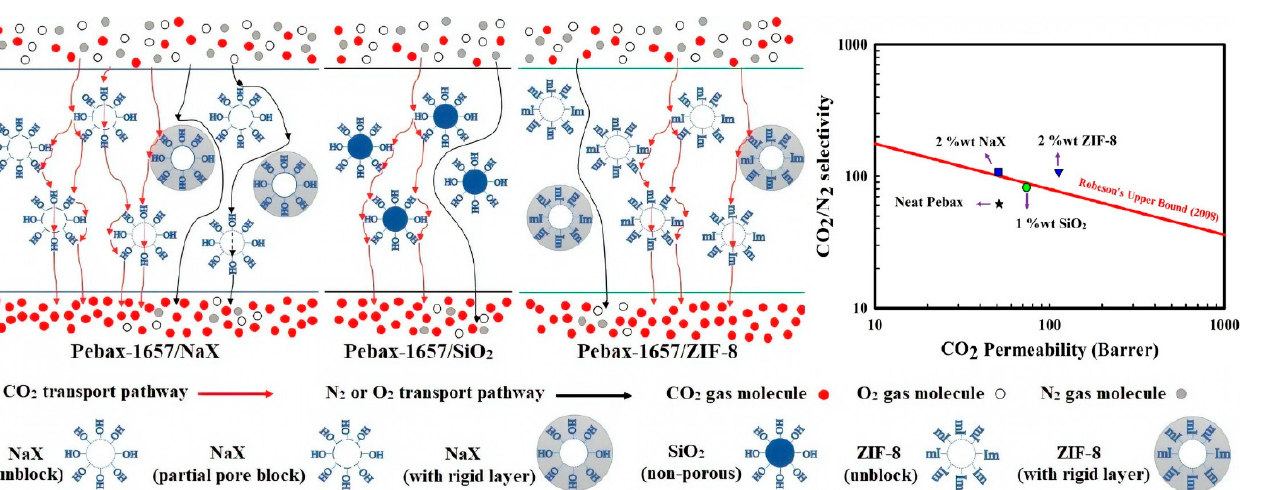
Figure 9. Scheme of MMMs loaded with porous (zeolites and MOFs) and non ‐ porous fillers (SiO 2 ) and their separation performance in a Robeson plot (from ref.